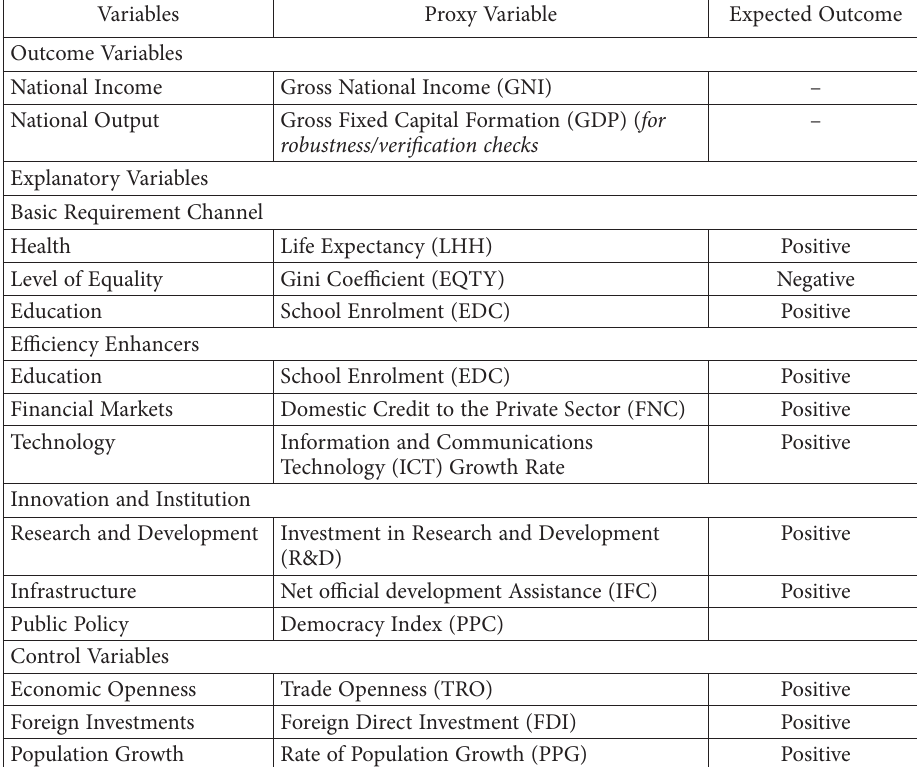
Table 1. Selected analytical variables (source: author’s selection) Variables Proxy